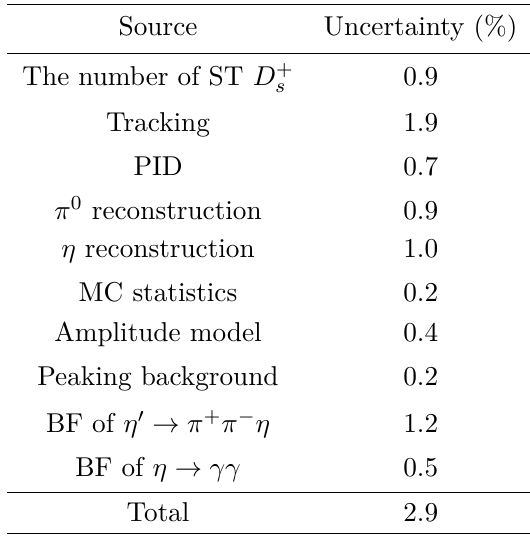
Table 9 . Systematic uncertainties in the BF